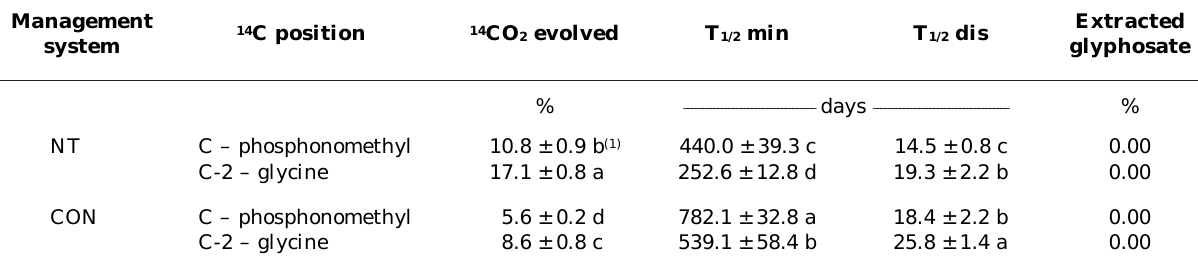
Table 2. 14 CO evolved, mineralization half-life (T 2 14 C-glyphosate, radiolabelled at different positions, in a Brazilian Rhodic Oxisol under 23 years of no-till (NT) or conventional management soil system (CON)